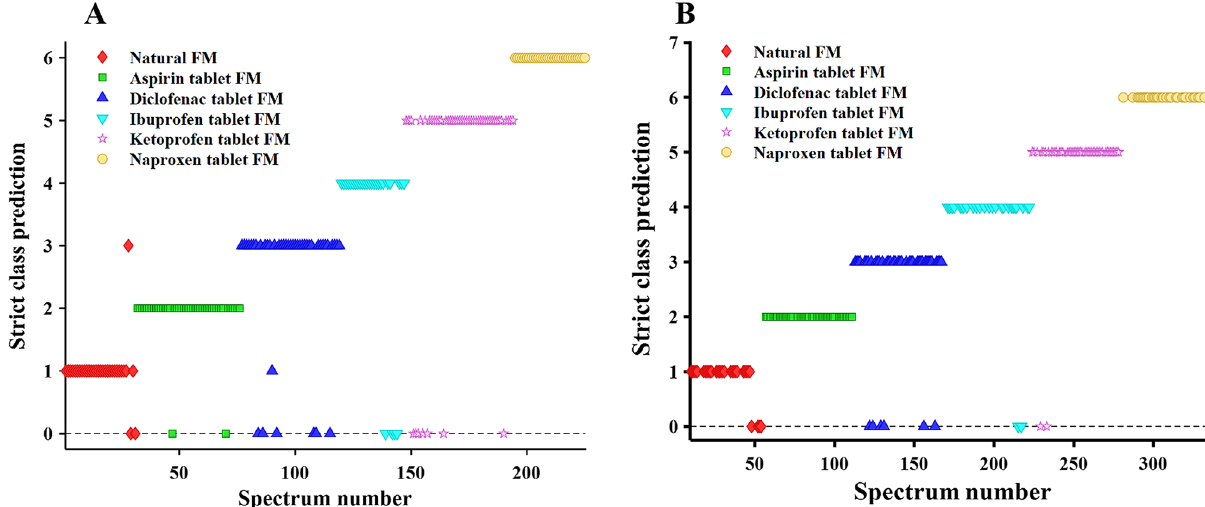
Figure 3. Cross validation prediction results of the PLS-DA model of each classification group using five latent variables: natural fingermark (red) and aspirin (green), diclofenac (navy blue), ibuprofen (light blue), ketoprofen (pink), and naproxen (orange) contaminated fingermarks ( A ) before applying GA and ( B ) after using the regions selected by